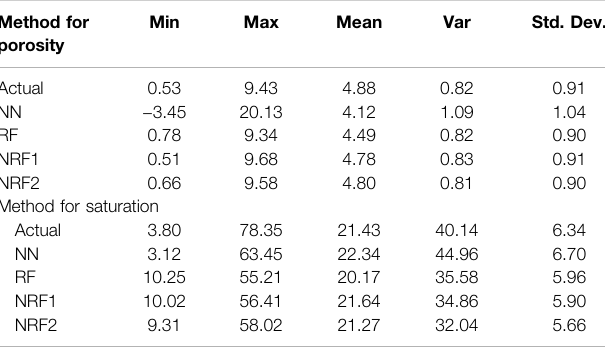
TABLE 3 | Qualitative analysis of data distribution for porosity and saturation from the actual data and predicted results. Method for